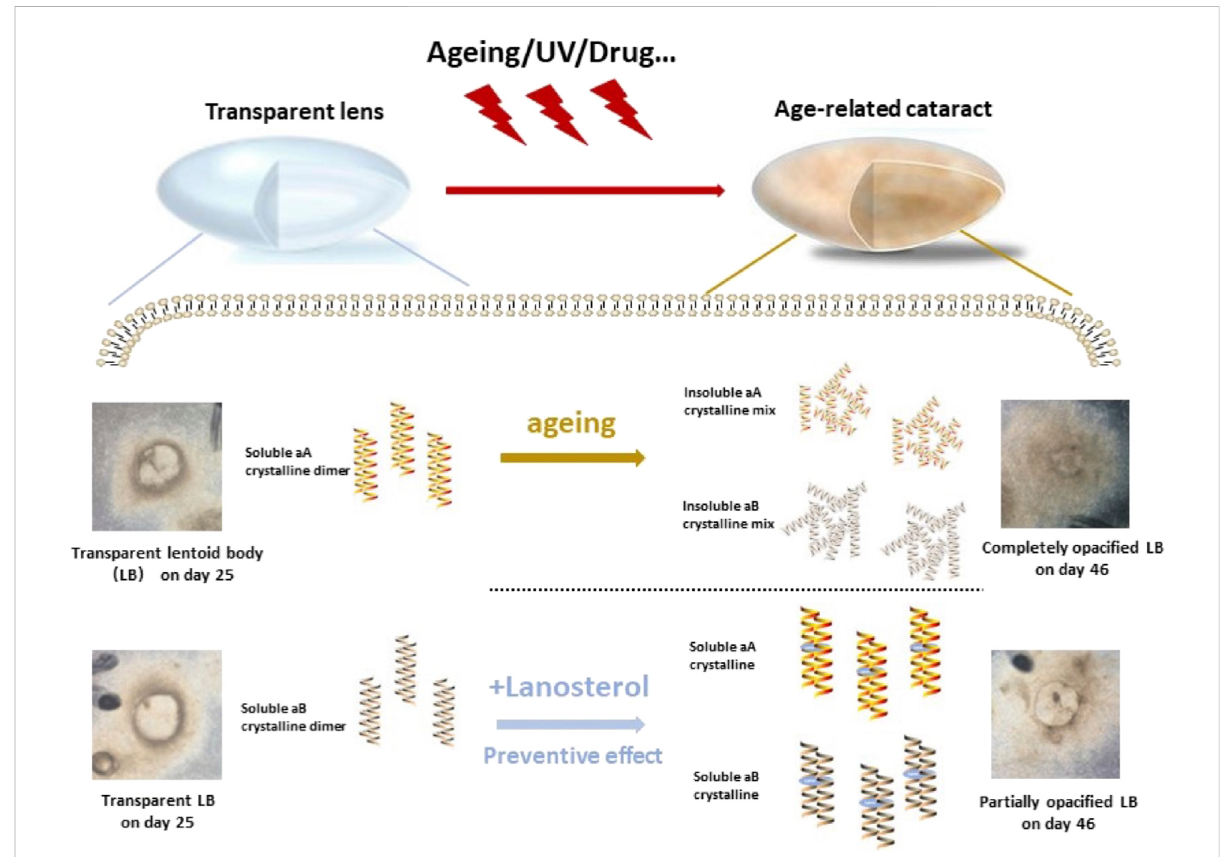
FIGURE 6 Graph abstract. The present study demonstrated that Mature LBs became cloudy with extended culture time while the opacity of LBs could be partially prevented by lanosterol treatment through maintaining the soluble of crystallin dimer.